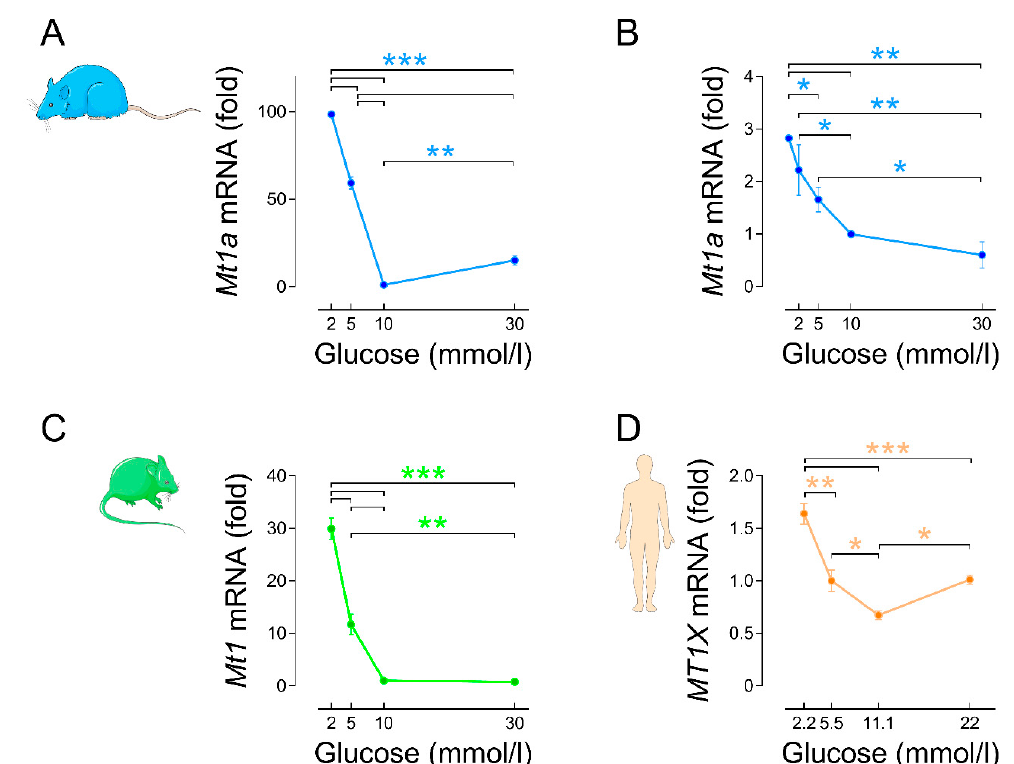
Figure 3. Mt1a , Mt1 and MT1X mRNA levels are downregulated by glucose stimulation. ( A ) Changes in the mRNA levels of Mt1a in rat islets cultured for 18 h in the presence of increasing glucose concentrations (G2, G5, G10, G30). Islet isolation and culture, RNA extraction and RT-real time PCR were performed as previously described [87]. The primers used for Mt1a and the housekeeping gene Tbp are the same as in [87]. Data are means ± SEM of n = 4 experiments. ( B ) Changes in the mRNA levels of Mt1a in the rat beta-cell line INS 832/13 cultured for 24 h in the presence of increasing glucose concentrations (G0.5, G2, G5, G10, G30). INS 832/13 cells were kindly provided by Dr. Christopher Newgard, Duke University. Cell culture, RNA extraction and real-time PCR were performed as previously described [91]. Data are means ± SEM of n = 3 experiments. ( C ) Changes in the mRNA levels of Mt1 in mouse islets cultured for 24 h in the presence of increasing glucose concentrations (G2, G5, G10, G30). Data were taken from [6] with permission of the publisher. Data are means ± SEM of n = 4 experiments. ( D ) Changes in the mRNA levels of MT1X in human islets from non-diabetic donors cultured for 24 h in the presence of increasing glucose concentrations (G2.2, G5.5, G11.1, G22). Data were taken from [6] with permission of the publisher. Data are means ± SEM of n = 3 experiments. * p < 0.05, ** p < 0.01, *** p < 0.001 for the indicated comparisons; one-way ANOVA with Newman–Keuls post hoc